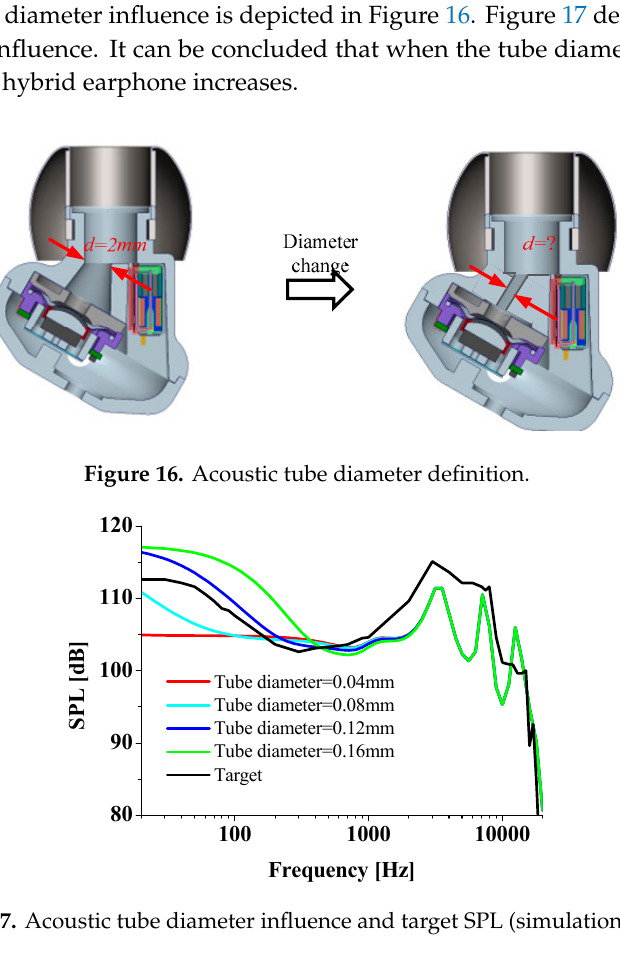
Figure 17. Acoustic tube diameter influence and target SPL (simulation result).